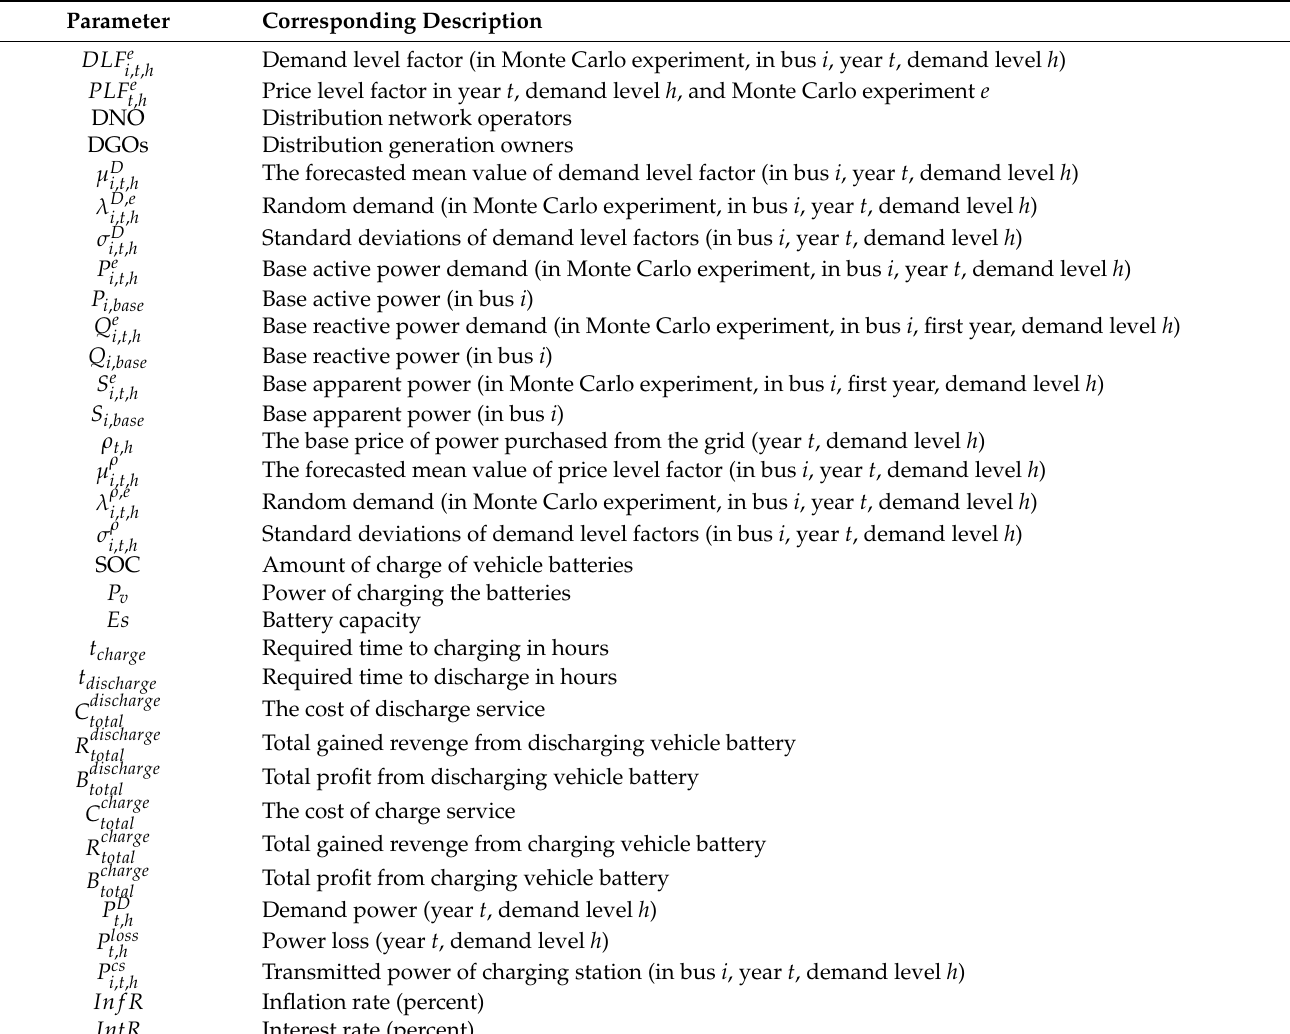
Table 1. The explanation of parameters associated with equations.